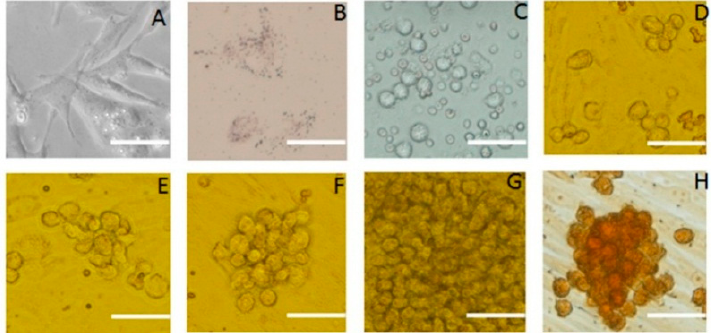
Figure 1. Morphology of SSCs and Sertoli cells in culture. Appearance under the microscope and various staining properties were used to identify the cells. ( A ) Sertoli cells derived from porcine testicular tissue; ( B ) Oil red-o staining of Sertoli cells; ( C ) Primary SSCs